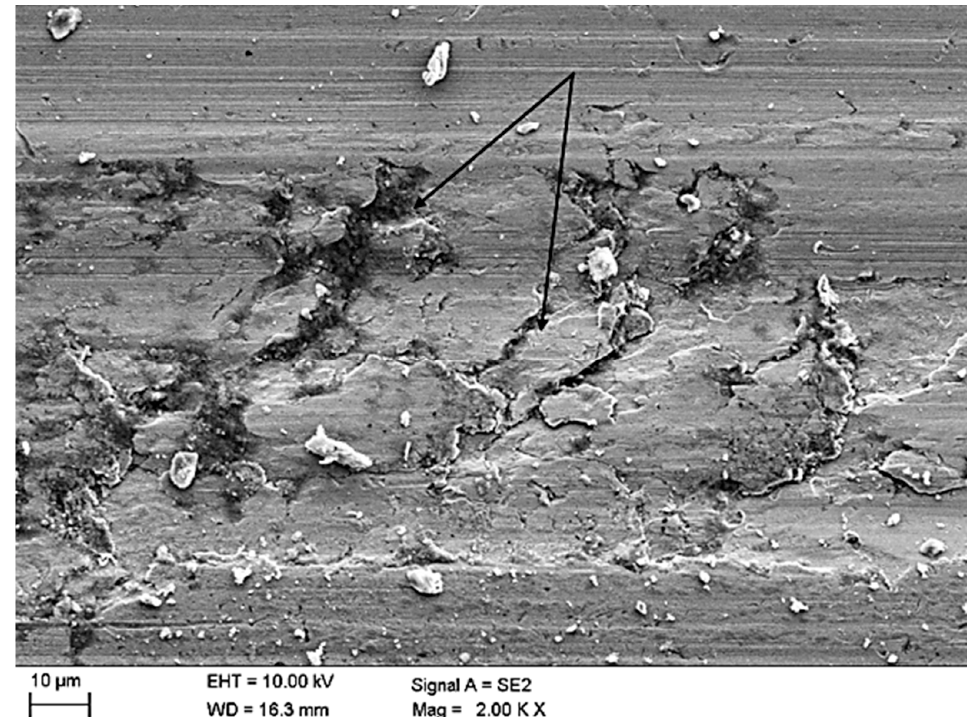
Figure 13. Steel sample surface worn as a result of the presence of clay coal abrasive material with visible surface cracks (indicated with arrows).